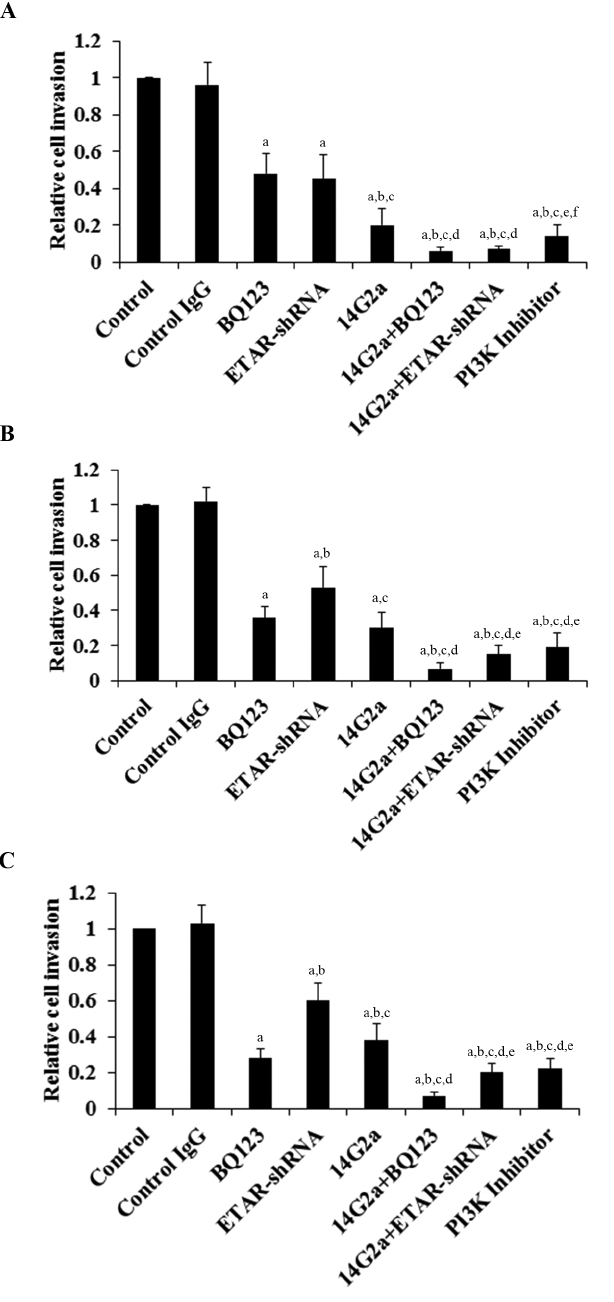
Figure 3. Effects of anti-ganglioside GD2 14G2a monoclonal antibody (mAb) alone or in combination with ET A receptor (ETAR) antagonist on matrix metalloproteinase-2 (MMP-2) mRNA levels in osteosarcoma (OS) cells. MMP-2 mRNA levels were determined by real-time RT-PCR in Saos-2 ( A ), MG-63 ( B ) and SJSA-1 ( C ) OS cells treated with control IgG (PK136 mAb, 50 m g/mL), 14G2a mAb (50 m g/mL), selective ETAR antagonist BQ123 (5 m M), and 14G2a (50 m g/ mL) + BQ123 (5 m M) for 48 hours. Cells with knockdown of ETAR (ETAR- shRNA) with or without 14G2a mAb treatment were also tested. Cells treated with selective phosphatidylinositide 3-kinase (PI3K) inhibitor BKM120 (50 m M) was used as a positive control. The MMP-2 mRNA level was shown as fold changes to that of the untreated control cells (designated as 1). Each experiment was repeated for three times in duplicates. Data values were expressed as Mean + SD. a p , 0.05 vs. control or control IgG; b p , 0.05 vs. BQ123; c p , 0.05 vs. ETAR-shRNA; d p , 0.05 vs. 14G2a; e p , 0.05 vs. 14G2a + BQ123; f p , 0.05 vs. 14G2a + ETAR-shRNA.